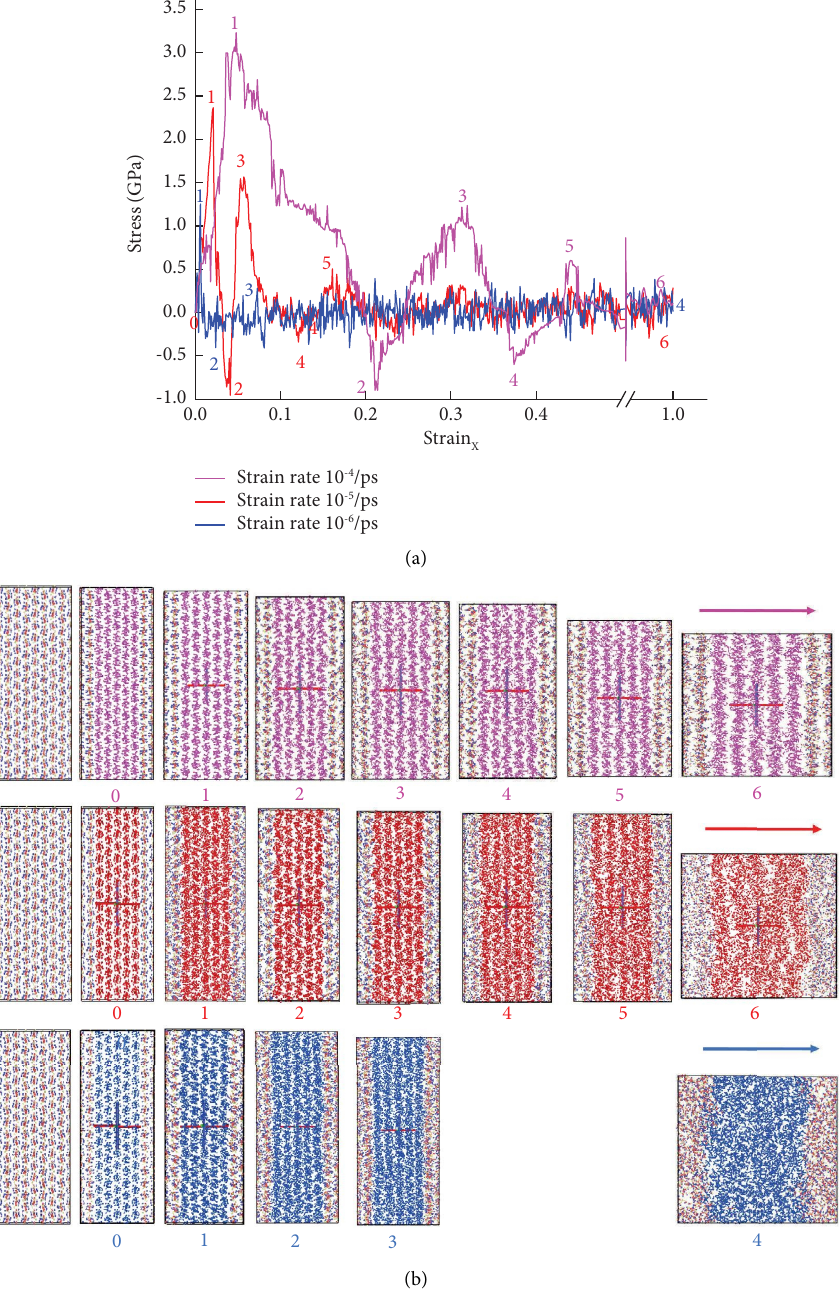
Figure 8: (a) Stress-stain behavior in the crystal system, (b) snapshots of the atomic structures viewed from the Y -direction at the points identifed at three strain rates, the arrows indicate the deformation direction (the numbers in fgures (a) and (b) correspond one to